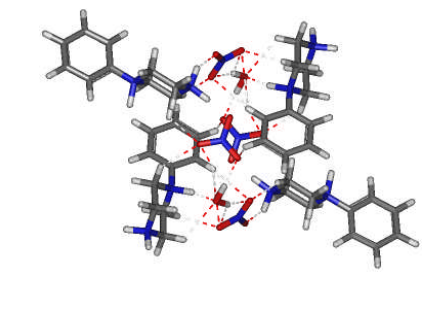
Figure 1 . ORTEP drawing of (C (NO ) .H O with the atom-labeling scheme. 3 2 2 Displacement ellipsoids are drawn at the 30% probability level. H atoms are represented as small spheres of arbitrary radii.